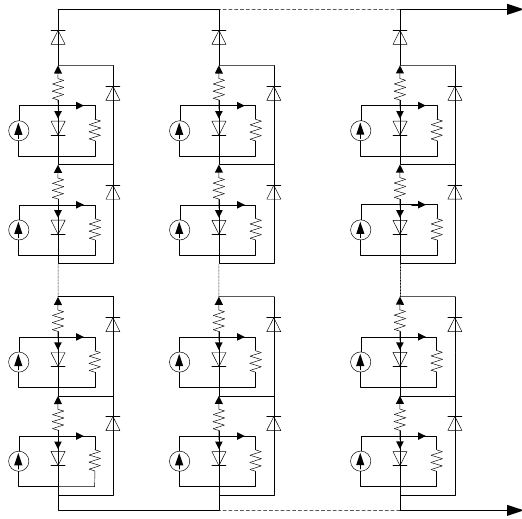
Figure 2. Equivalent circuit model of a PV module.